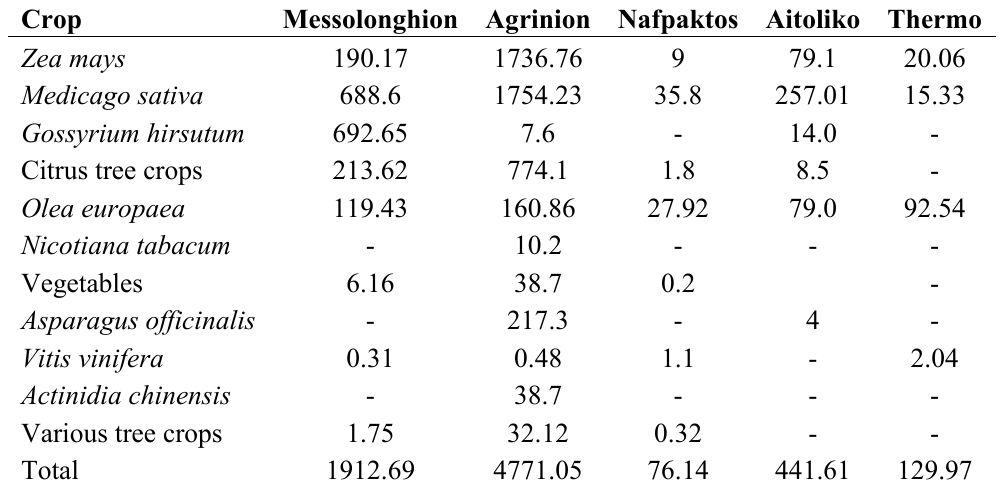
Table 2. Total area (ha) in five study areas cropped during